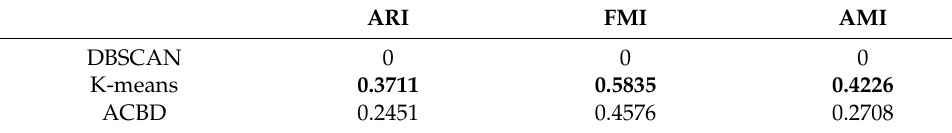
Table 3. Comparison of Wine experimental results.